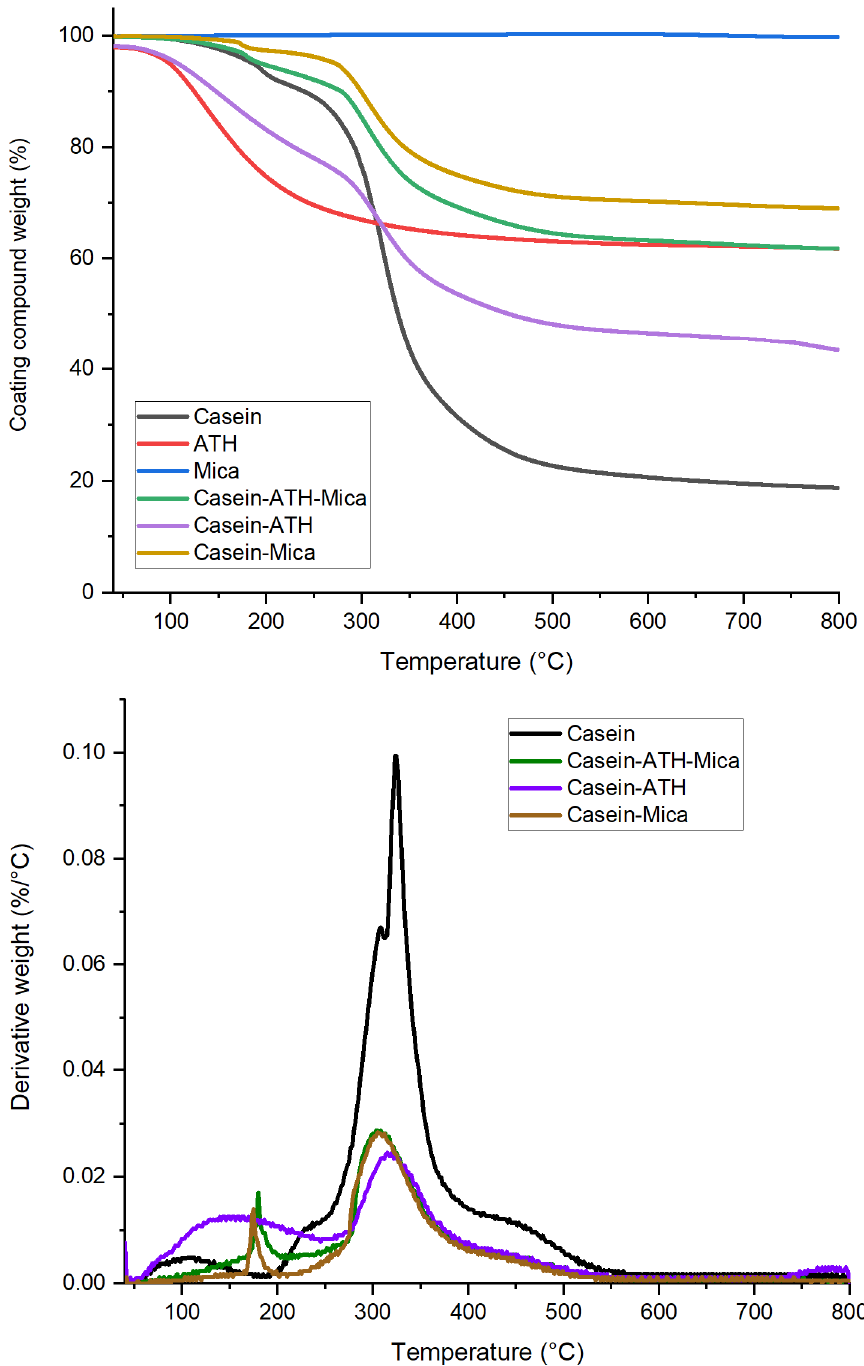
Figure 4. TGA ( above ) and DTG data ( below ) from coating compounds as a function of the temperature for pure casein, mica, and ATH, and also mixtures of Casein–ATH–Mica, Casein–ATH and Casein–Mica.